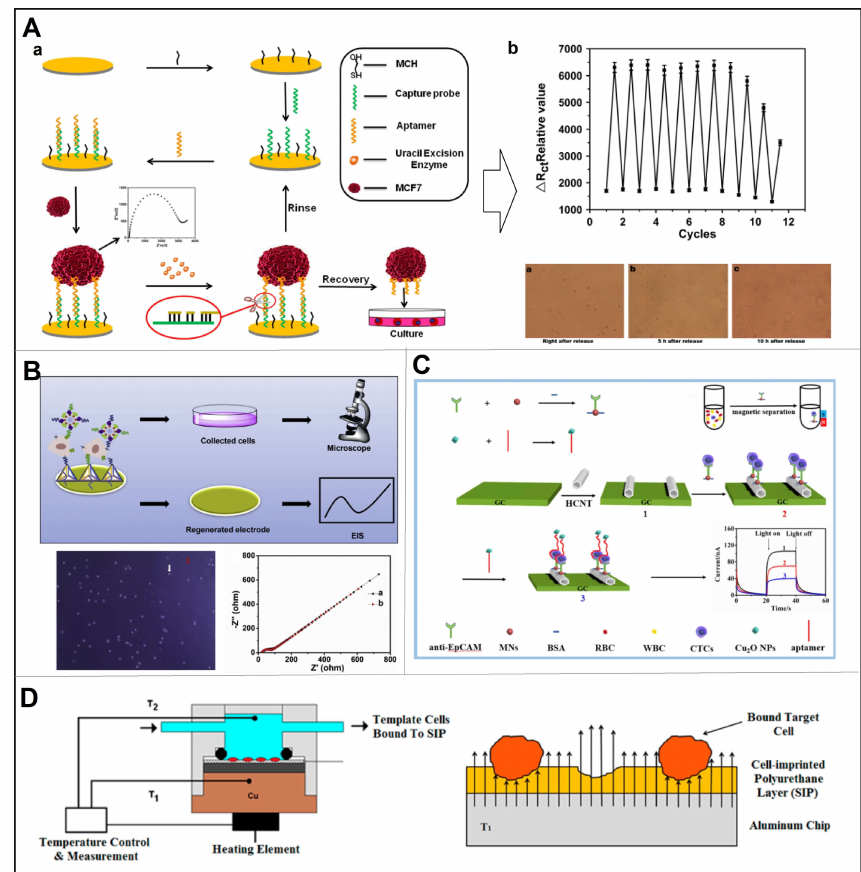
Figure 7. ( A ) Sensor fabrication process ( a ), as well as cycling experiment results and cell viability microscope images ( b ). Reproduced with permission from [58]. ( B ) Schematic illustration of the sensor for cell release, with the microscope image of trypan blue staining of collected cells (the red arrow points to the dead cell, the white arrow points to the living cell), as well as EIS of ( a ) bare electrode and ( b ) the regenerated electrode. Reproduced with permission from [61]. ( C ) Schematic representation of CTC measurement in whole blood based on MNs isolation of CTCs and Cu 2 O- aptamer as signal probe. Reproduced with permission from [62]. ( D ) Schematics of the measuring setup and illustration of cell binding to the binding cavities of the SIP, thereby blocking the heat transfer from the chip to the liquid. Reproduced with permission from